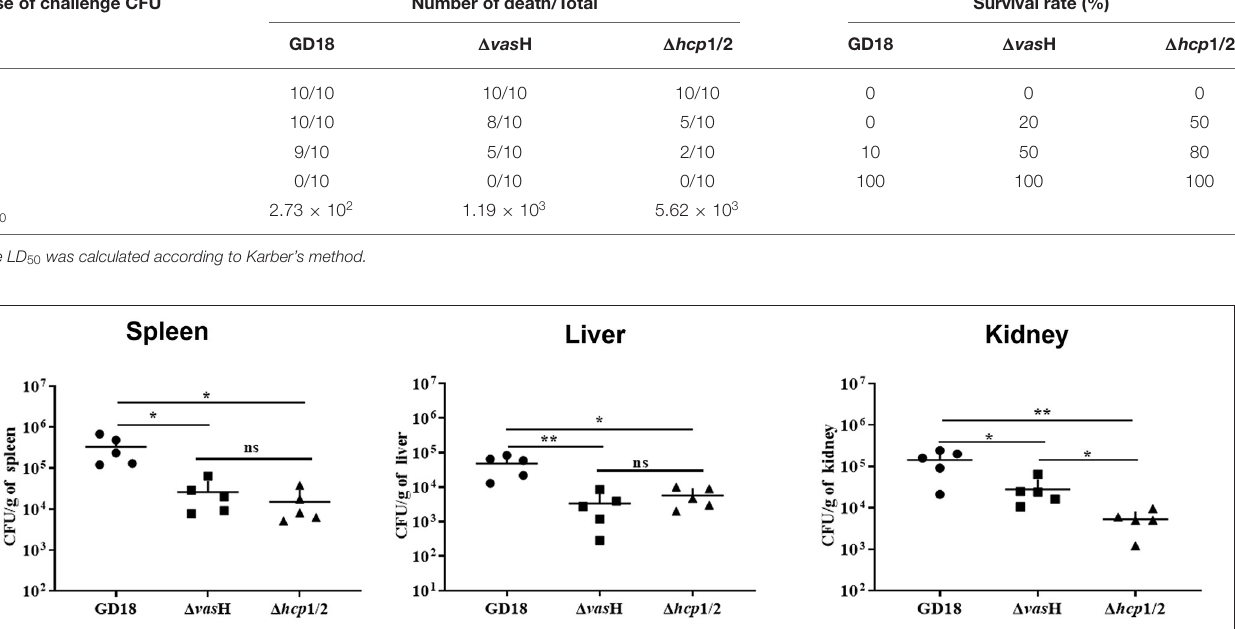
TABLE 3 | Calculations of LD 50 s of the A. hydrophila GD18 and mutant strains in zebrafish. Dose of challenge CFU Number of death/Total